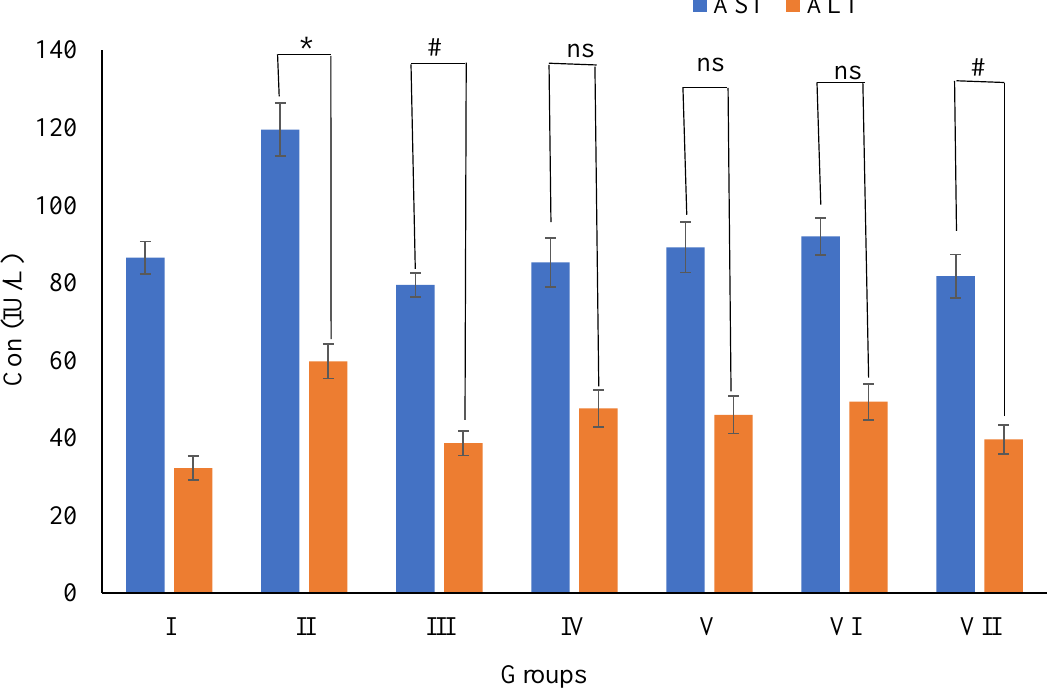
Figure 10. Effects of Wt-F of B. diffusa extract on AST and ALT levels in SD rats after 60 days of treatment. Where AST= Aspartate aminotransferase; ALT = Alanin pyrophosphate. Data are expressed as Mean ± SEM of 6 rats in each group. p -value = * < 0.01 showed significance compared with respective group I, p -value = # < 0.01 showed significance compared with respective group II and ns = non-significant compared with respective group II.